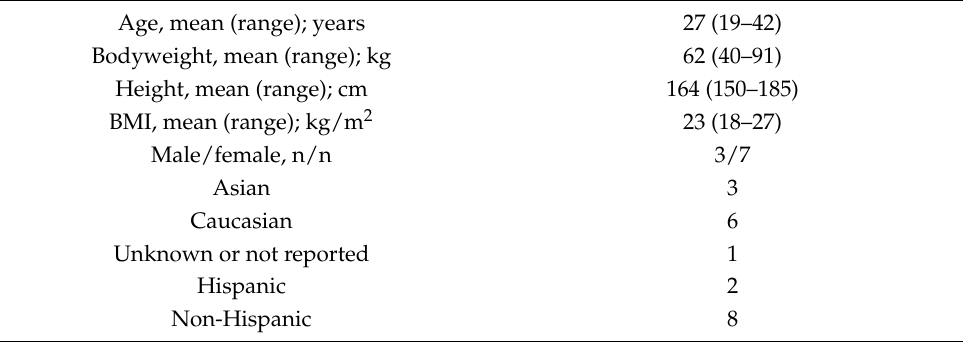
Table 1. Baseline and demographic characteristics of lactose maldigesters enrolled in the trial.